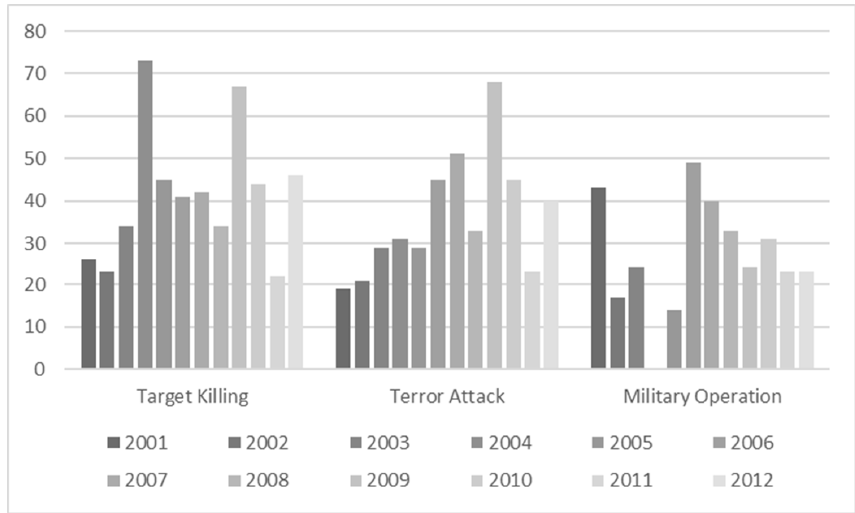
Figure 20. Annual TIS values for each type of event, for the time period 2001–2012.